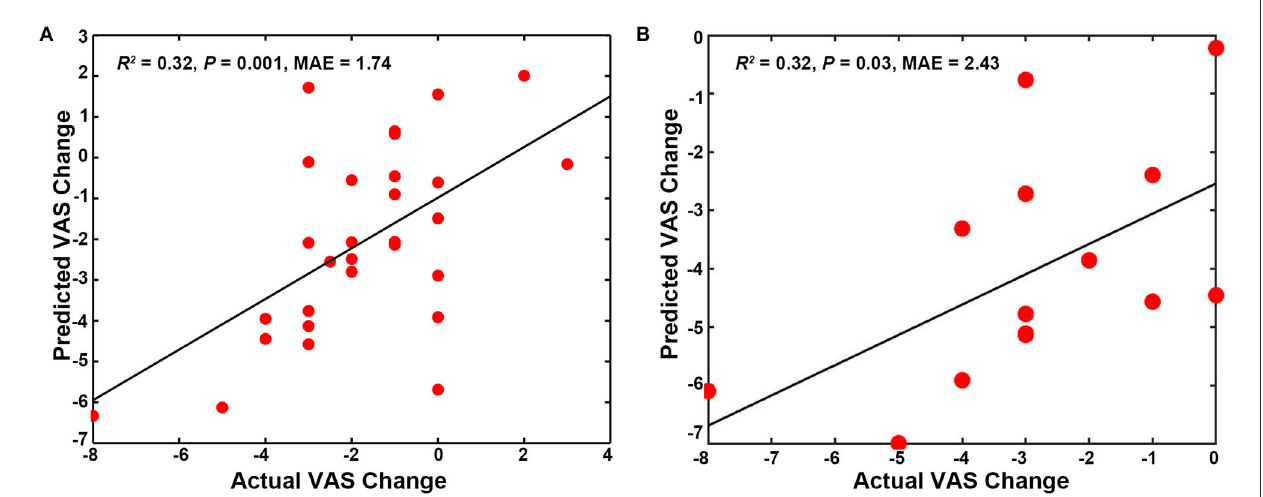
FIGURE 4 | Predicting treatment effects using baseline SUVR patterns in special networks. (A) SUVR pattern in the SMN and DMN as a predictor for the pooled group. (B) SUVR pattern in the DMN as a predictor for the real acupuncture treatment group. DMN, default mode network; SMN, sensorimotor network; SN, salience network; SUVR, standardized uptake value